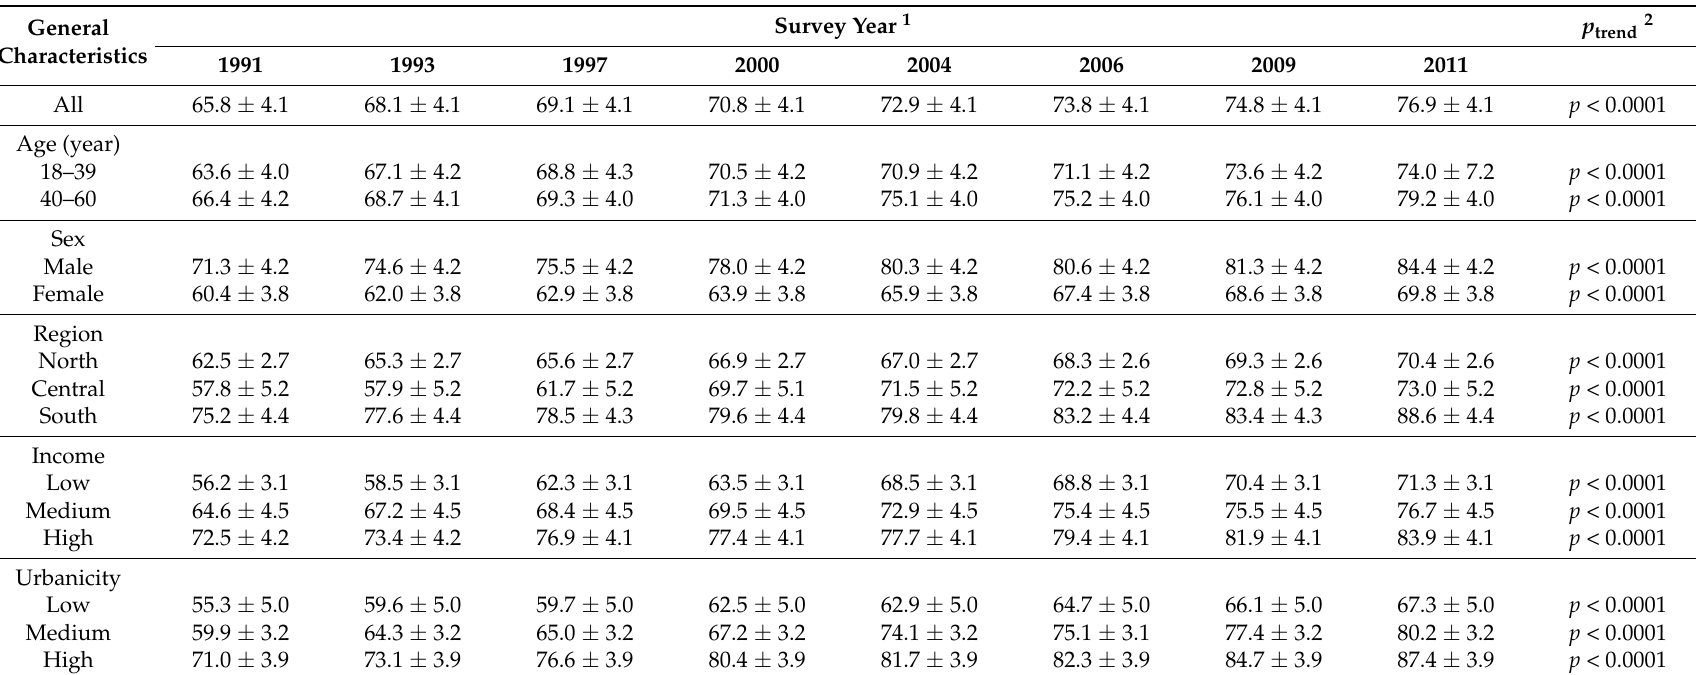
Table 4. Daily fat intake (g), by age, sex, geographical region, income, and urbanicity, in Chinese rural adults from 1991 to